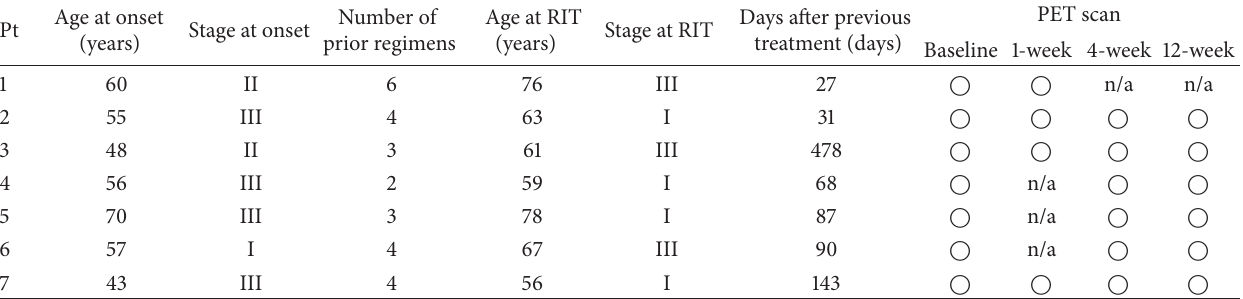
Table 1: Patient population